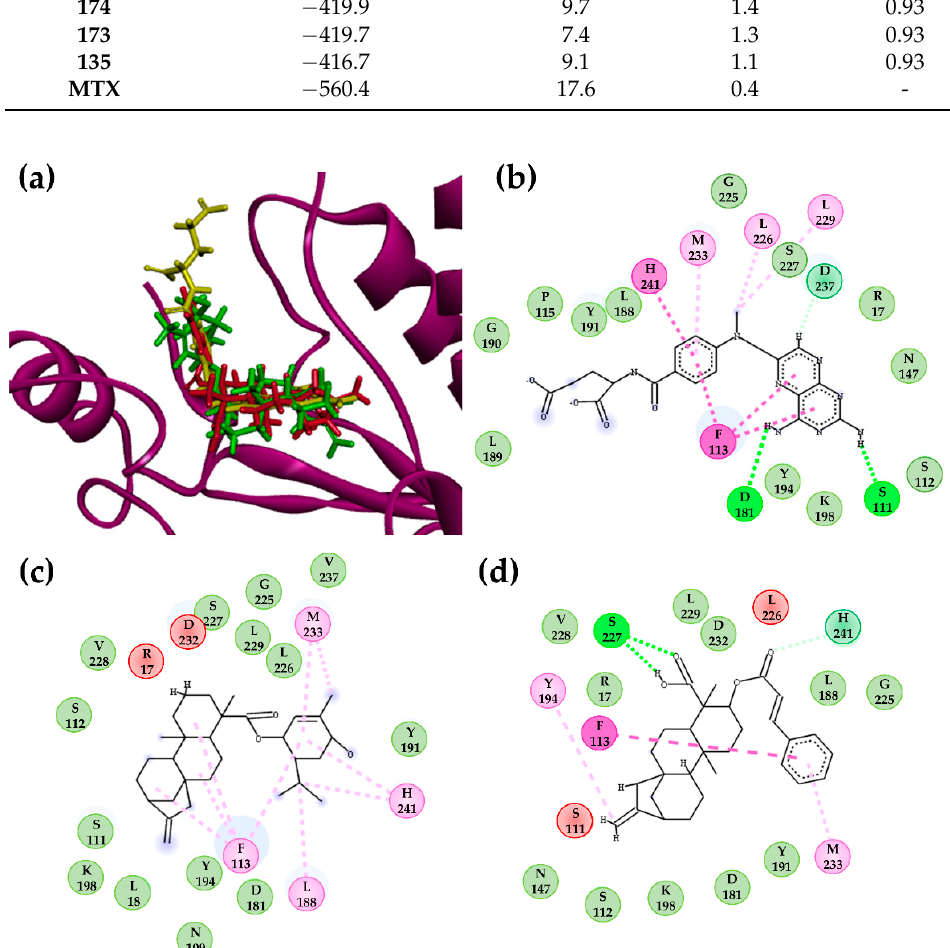
Figure 2. ( a ) Docking conformations of structure 135 (green) , 302 (red) and MTX (yellow) in the active site of Lm PTR1; 2D-residual interaction diagrams of ( b ) methotrexate (MTX), ( c ) structure 135, and ( d ) structure 302 . Interacting residues are shown as colored circles depending on the interactions (as colored dashed lines): H-bond (lime), Van der Waals (green), π – π (purple) and π –alkyl (pink), unfavorable (red), and carbon H-bond (teal) interactions. Methotrexate achieved a docking score of − 560.4 kJ/mol in the active site of Lm PTR1, and the formation of two H-bond interactions with S111 and N118 were observed (Figure